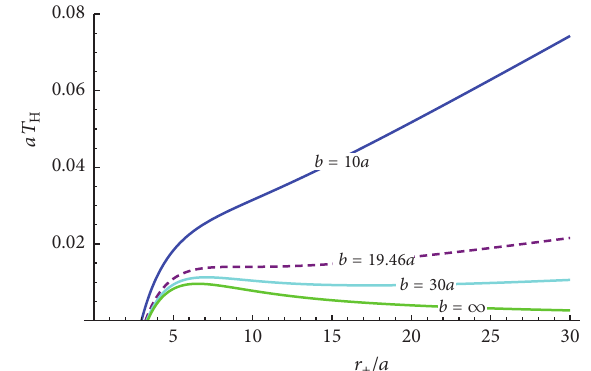
Figure 5: Plot of the Hawking temperature 𝑇 H with respect to 𝑟 + under different vacuum pressure. The blue, cyan, and green solid curves correspond to the cases of 𝑏/𝑎 = 10 , 30 , and ∞ , respectively, andtheextremalradiiinthethreecasestake 𝑟 0 /𝑎 = 3.000 ,3.325,and 3.384, respectively. The dashed purple curve corresponds to 𝑏/𝑎 = /𝑎 = 3.253 , that is, the critical case where the maximum 19.46 and 𝑟 0 and minimum of temperature coalesce.